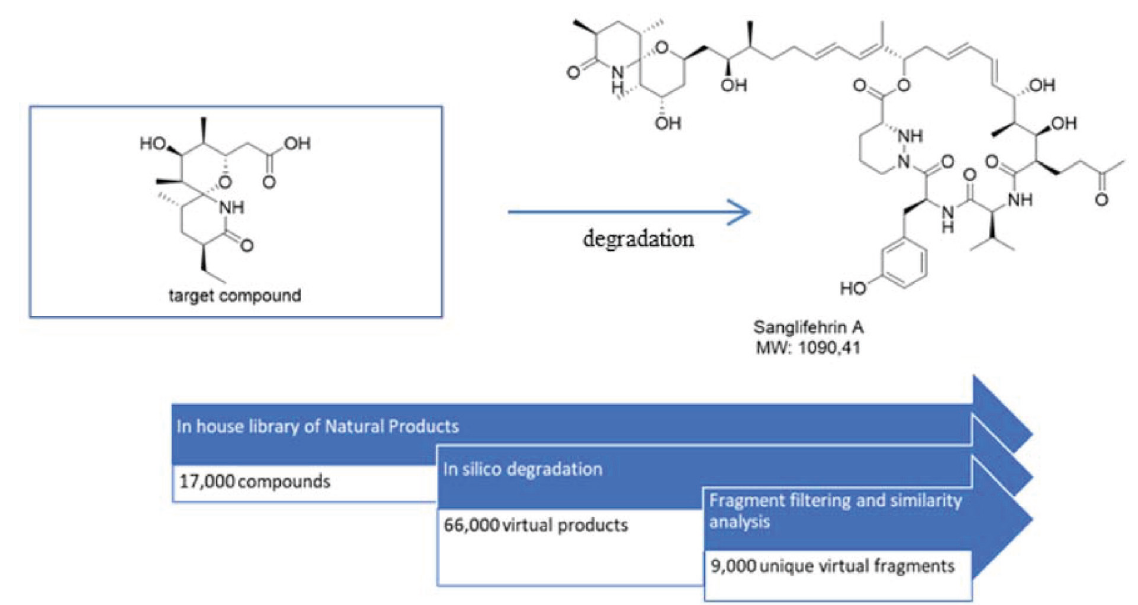
FIGURE 10 - Virtual degradation toward fragment library development. TABLE I - Ring-distortion strategies and structural changes Ring-cleavage Ring-expansion Ring-fusion Ring-rearrangement structural changes novel ring skeletons addition of constrained ring new functional groups Increase of flexibility